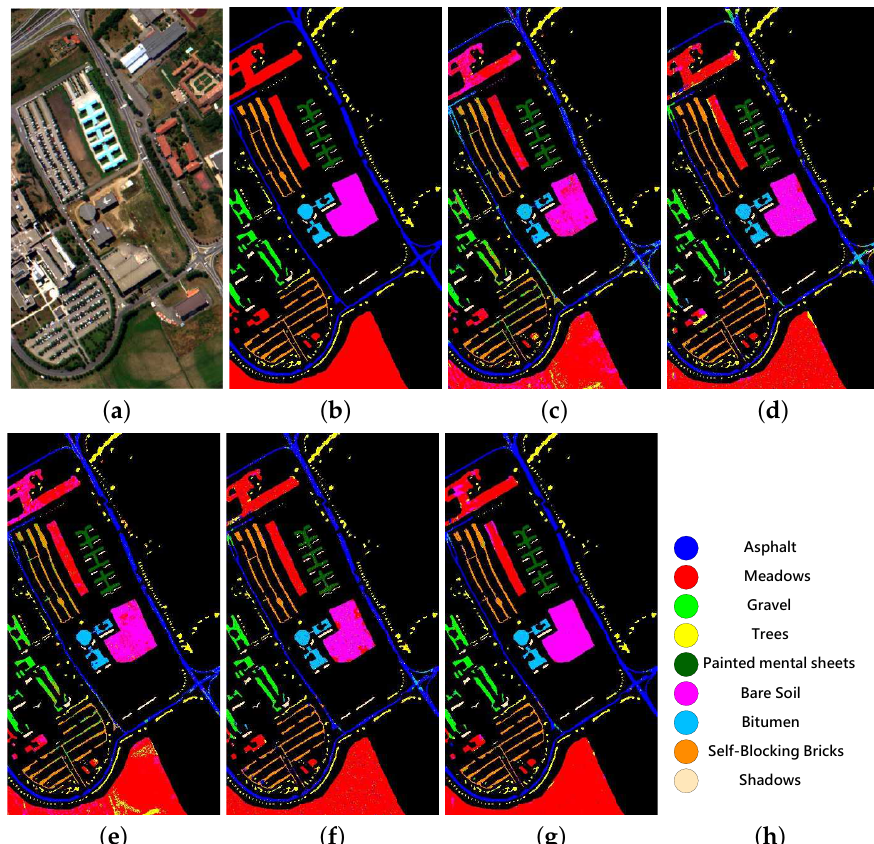
Figure 8. Classification maps using different methods on the Pavia University dataset: ( a ) False-color Table 8. Classification performance of different methods for the Pavia University dataset. Bold indicates the best